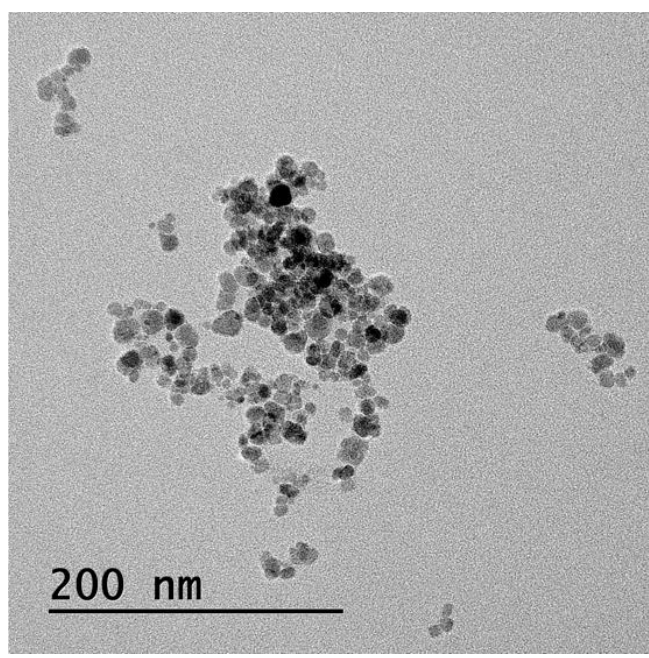
Figure 4. TEM image of SPIONs.